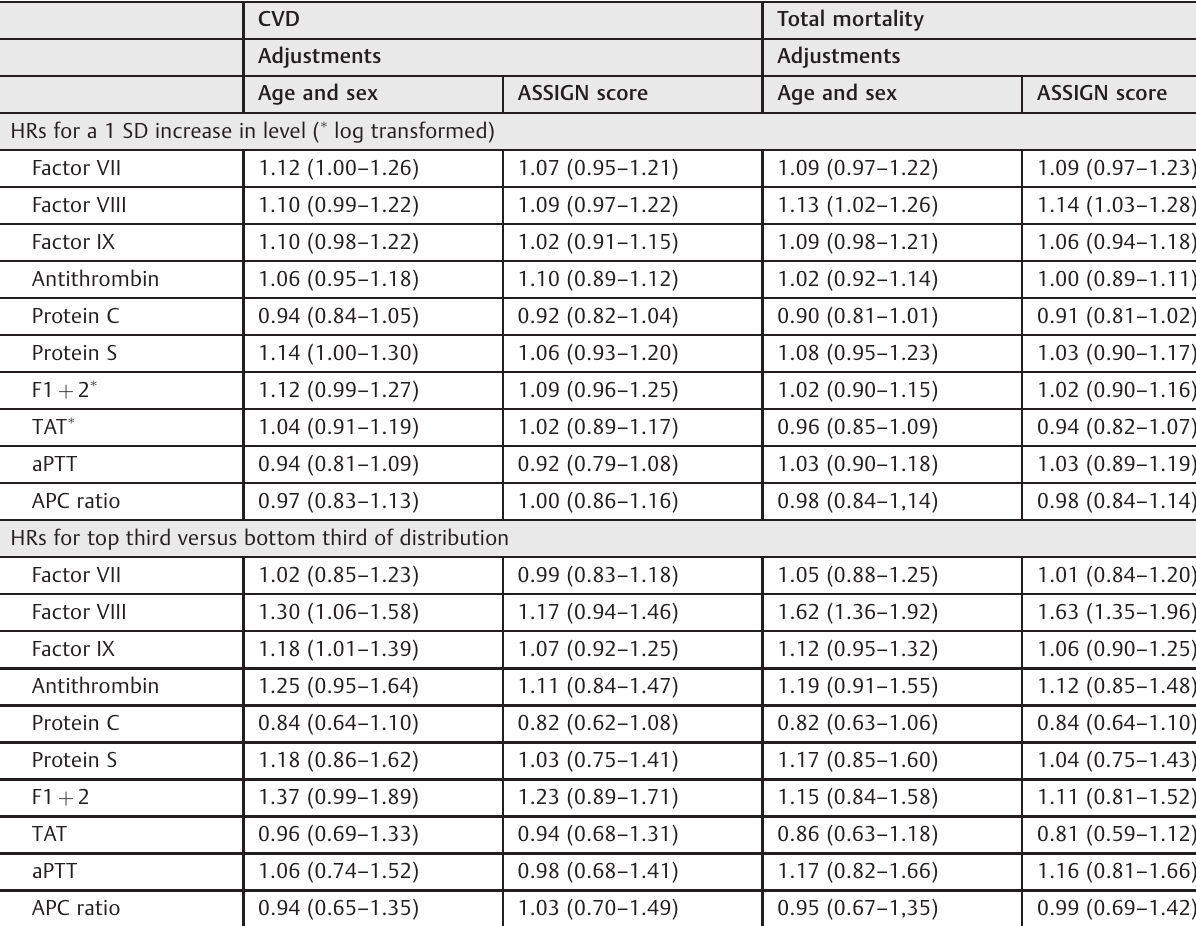
Table 4 Associations with outcomes: 1992 MONICA survey